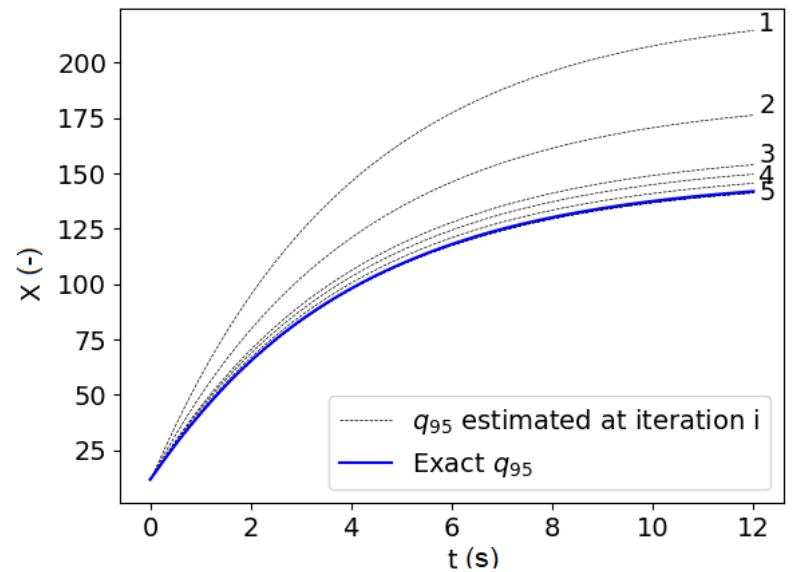
Figure 8. Evolution of the estimated q 95 along the 10 active-learning iterations. In addition, in Figure 9, the evolution of the quantile estimation and the confidence area are displayed before the refinement (left) and after the 10 active learning iterations (right). At the end of the refinement process, the estimated quantile converges to the exact quantile and the confidence area is tighten around the exact